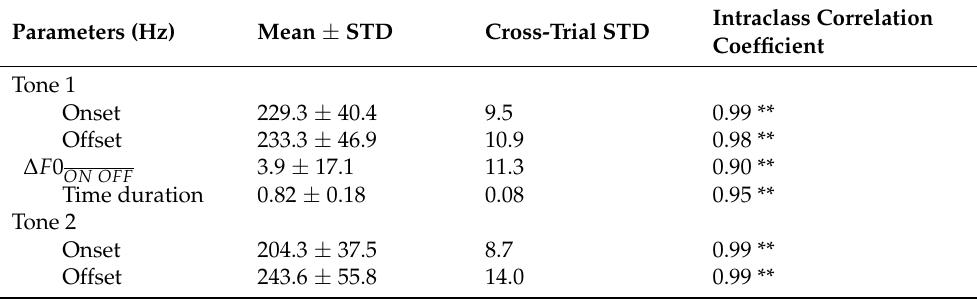
Table 3. Test-retest reliability of temporal and frequency parameters in the acoustic voice